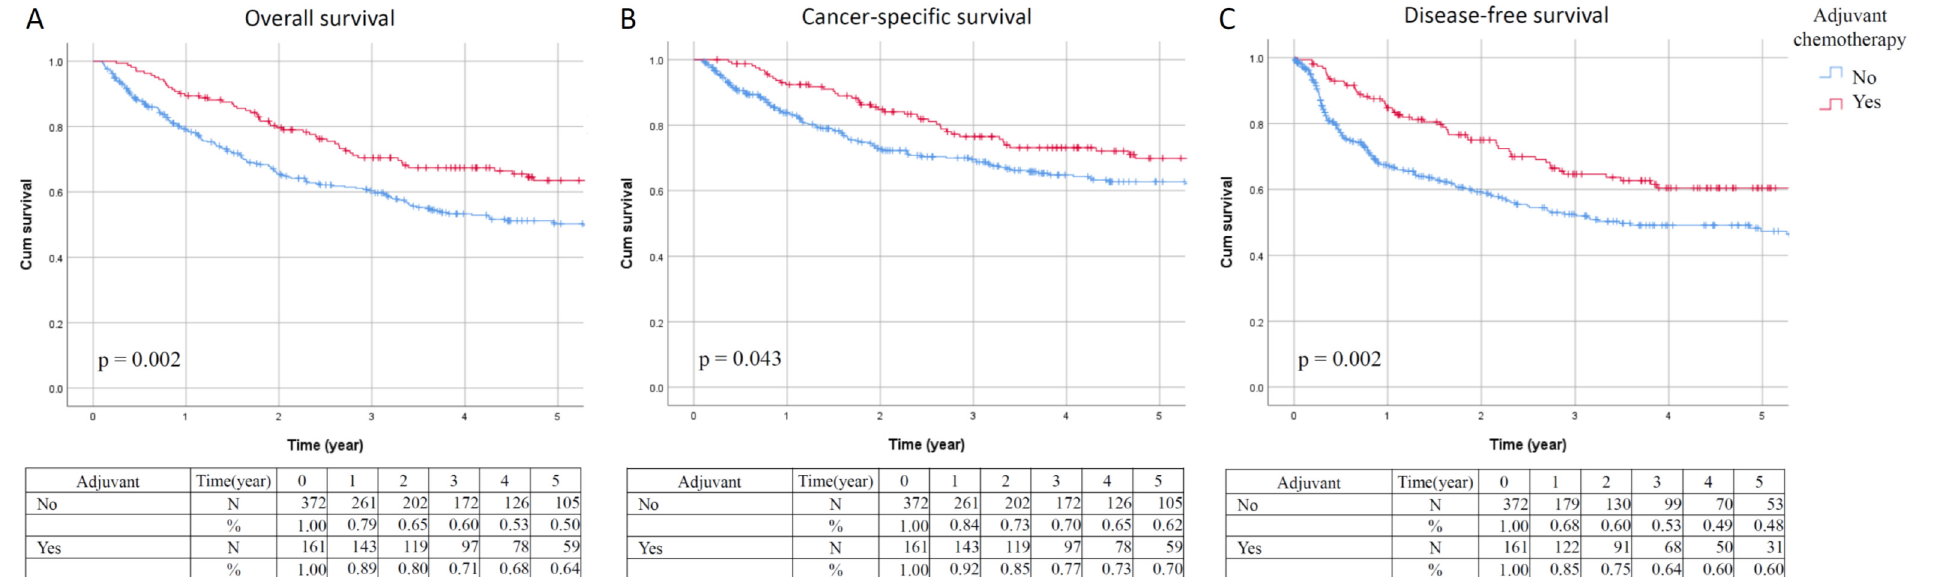
Figure 1. Kaplan–Meier estimates of overall survival ( A ), cancer-specific survival ( B ), and disease-free survival ( C ).